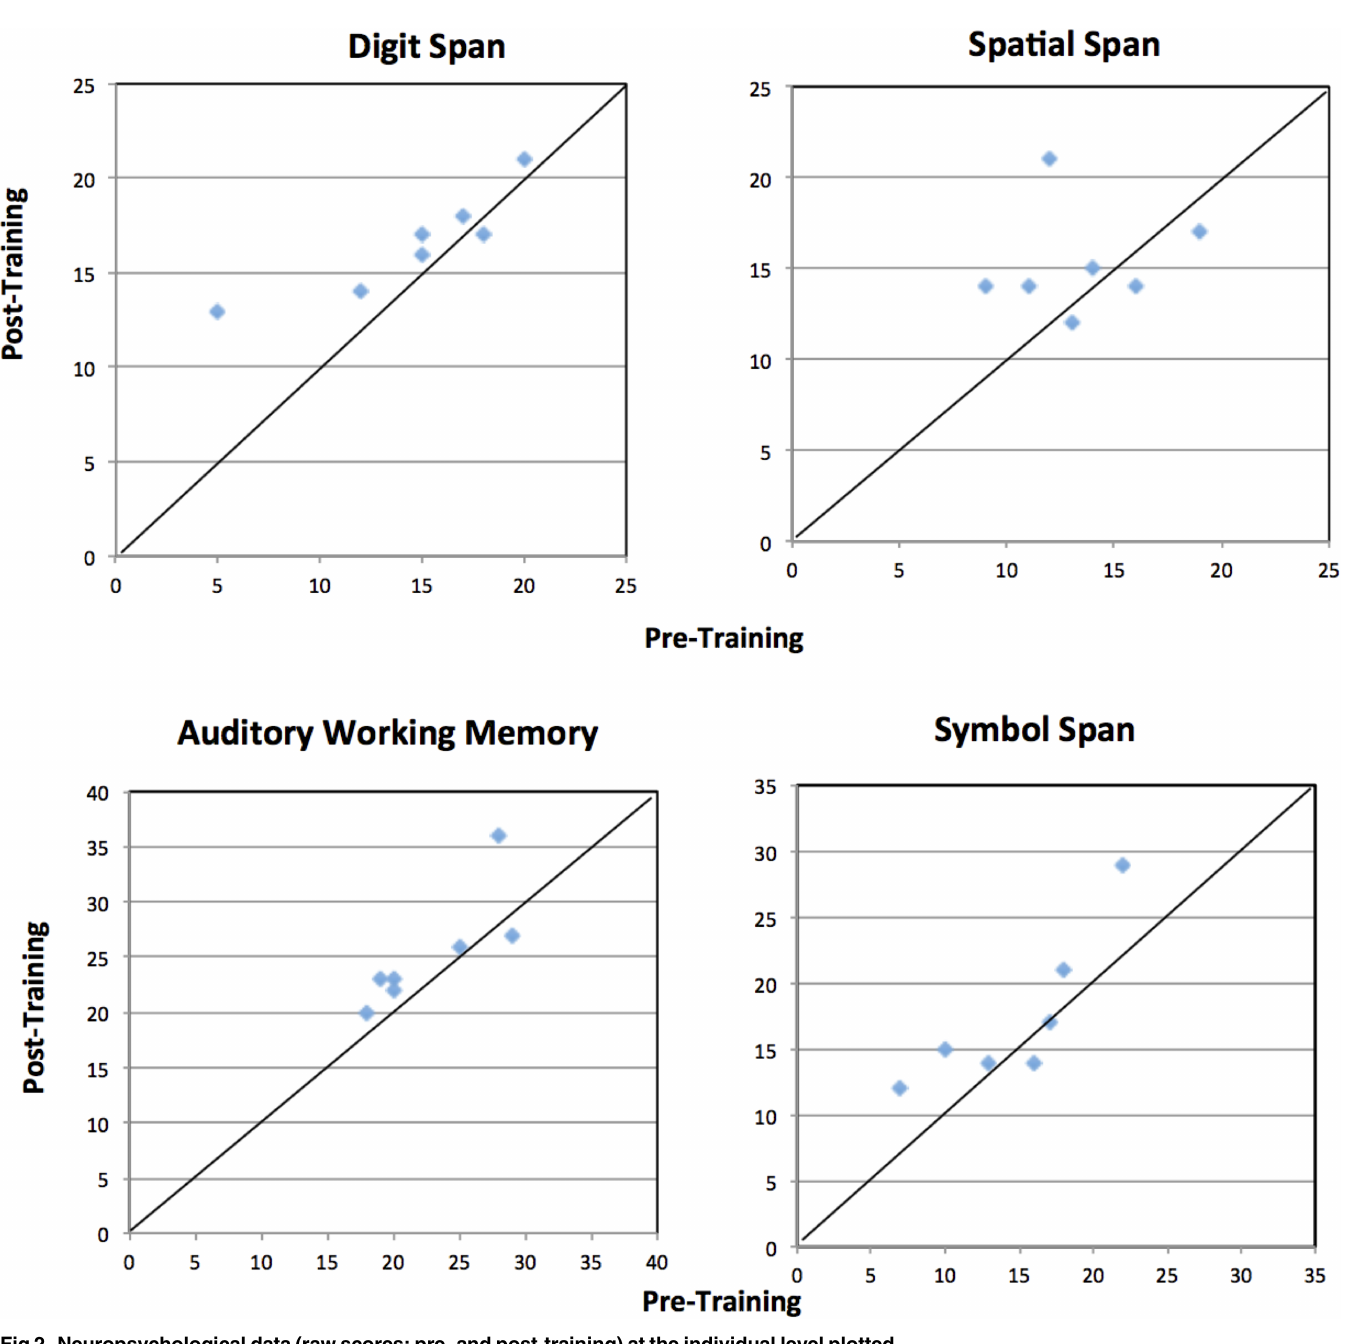
Fig 2. Neuropsychological data (raw scores;pre- and post-training) at the individual level plotted.